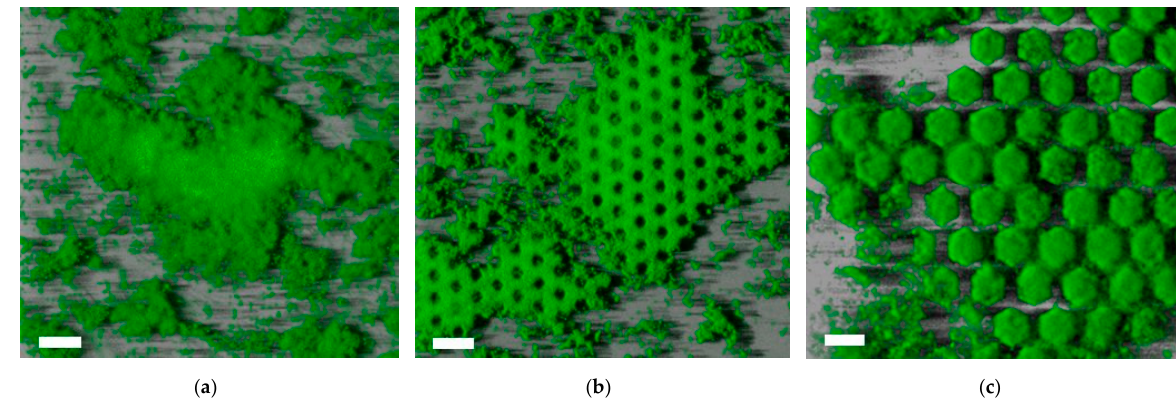
Figure 2. Confocal laser scanning micrographs showing bacterial biofilm of P. inhibens attached on the fabricated silicon surfaces. Biofilms were incubated with low stirring for 48 h at 25 °C: ( a ) Biofilm grown on a planar surface; ( b ) Biofilm grown on honeycomb pillars; ( c ) Biofilm grown on honeycomb pits. Scale bar is 20 µm.